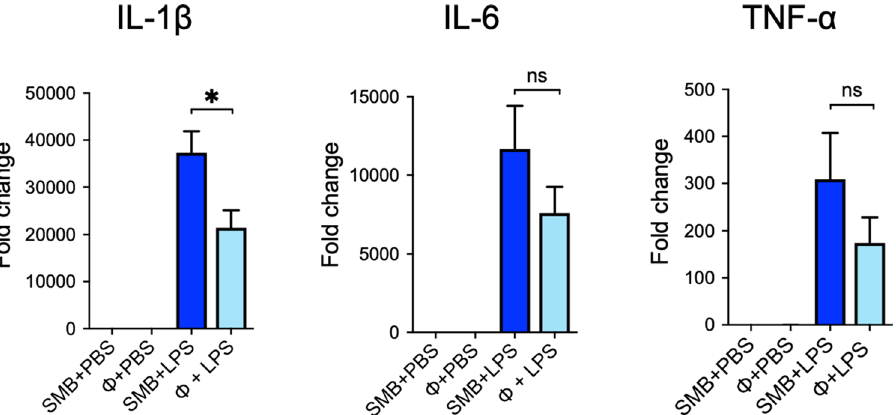
Figure 7. Effects of phiMR003 on the induction of cytokine transcription in mouse peritoneal macrophages. Transcripts of IL-1β, IL-6, and TNF-α were quantified in the presence (ϕ) or absence (SMB, SM buffer) of phiMR003. PBS was added instead of LPS as a control. Data indicate the mean of three independent experiments. Error bars indicate the standard errors of the means (SEMs). The Mann ‒ Whitney U test was used to determine the significance of the data (n.s., not significant; *, P < 0.05).